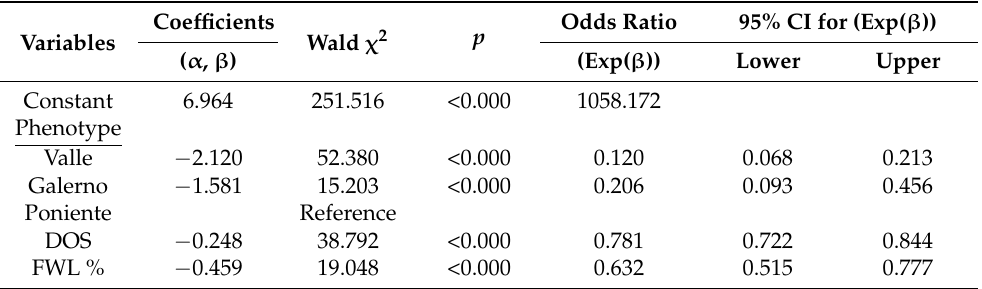
Table 12. Estimation of the multiple logistic regression parameters for the Galerno, Poniente, and Valle cucumber